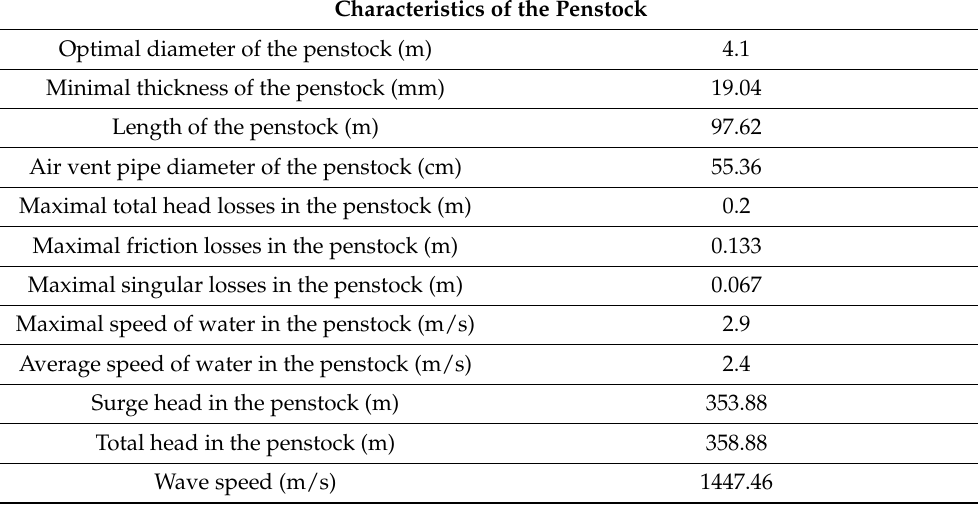
Table 12. Characteristics of the designed